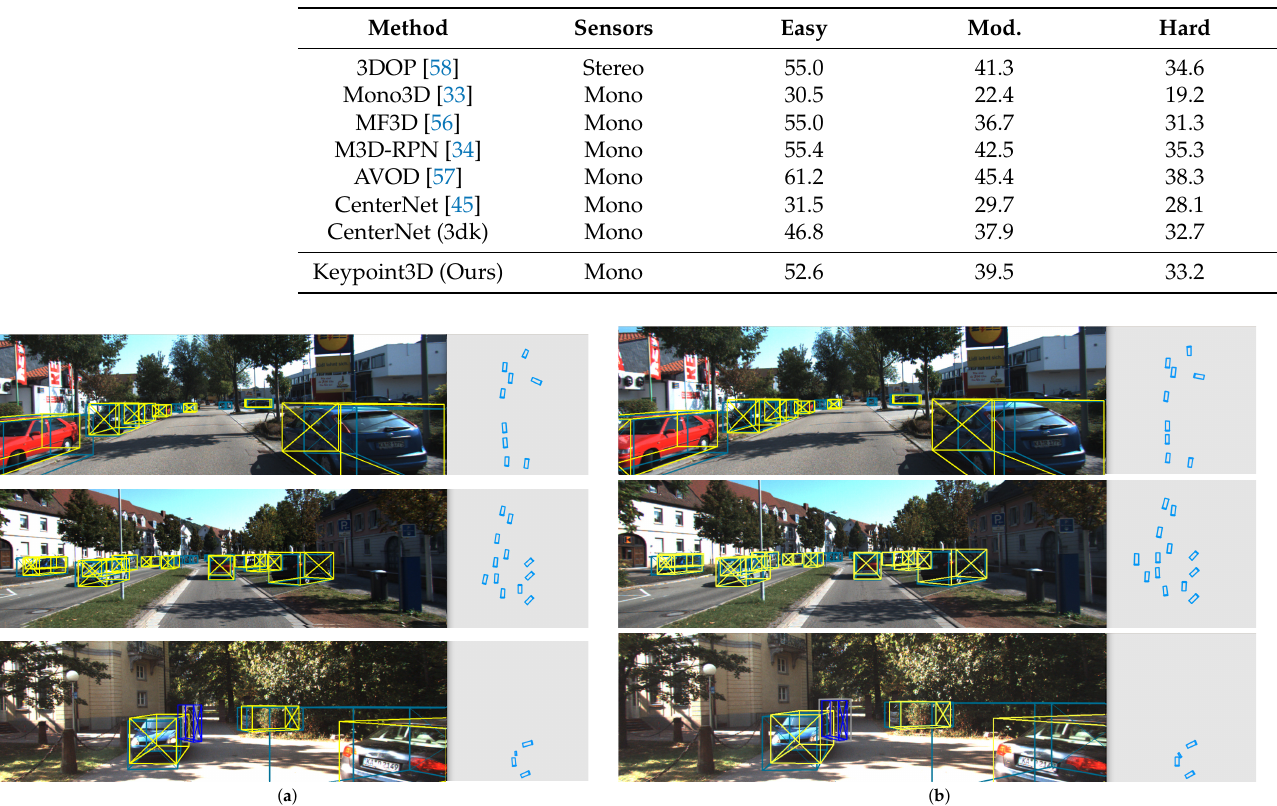
Table 4. 3D localization performance as per the KITTI val set in car. The 3D location performance is evaluated by the average precision ( AP loc ) (in %) of BEV boxes as per the KITTI val set ( IoU = 0.5).